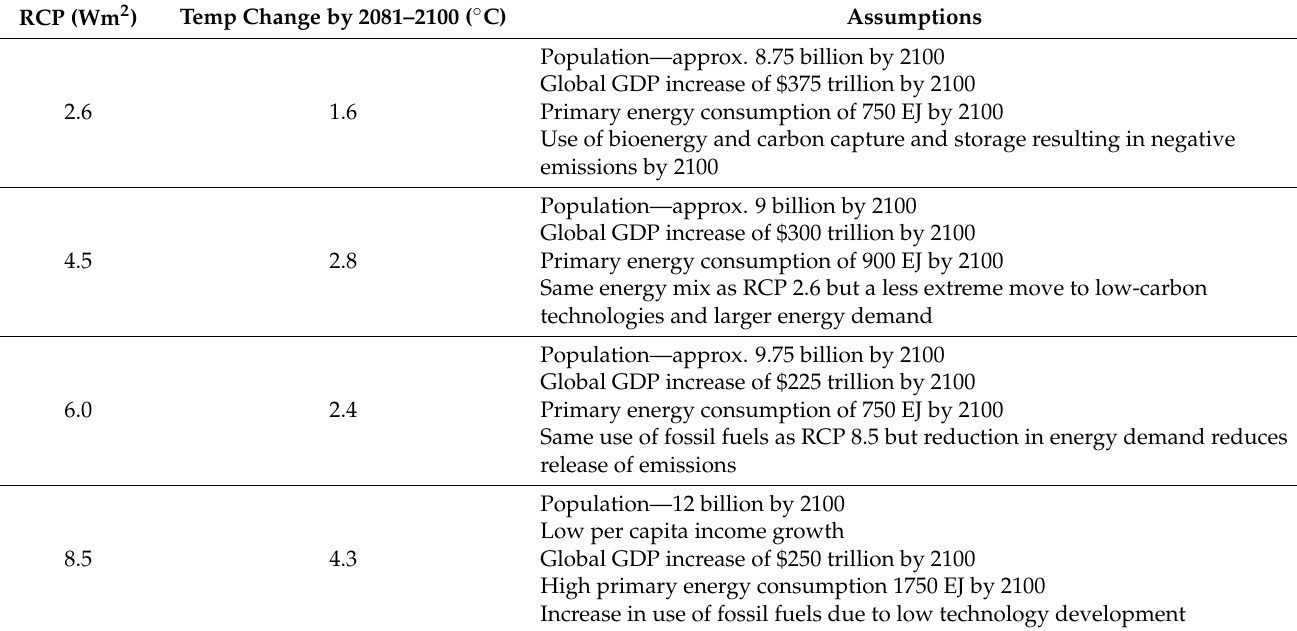
Table 3. RCPs and their resulting global mean surface temperature change from pre-industrial baseline by 2100 (adapted from Met Office [51] and van Vuuren, et al.